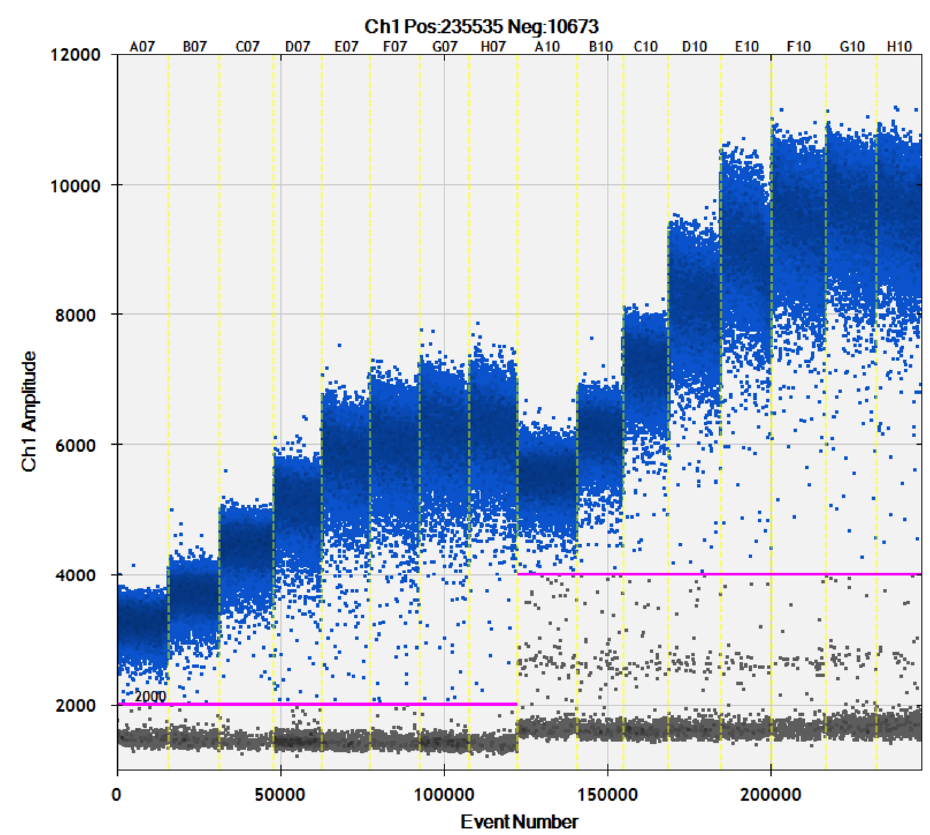
Figure 2. Robustness of ddPCR conditions for SET1 and SET2. The horizontal axis shows ddPCR amplifications using SD4.0 at different annealing/extension temperatures. Lanes 1 and 9: 65.0 ◦ C, lanes 2 and 10: 64.0 ◦ C, lanes 3 and 11: 62.4 ◦ C, lanes 4 and 12: 59.9 ◦ C, lanes 5 and 13: 57.0 ◦ C, lanes 6 and 14: 54.4 ◦ C, lanes 7 and 15: 52.9 ◦ C, and lanes 8 and 16: 52.0 ◦ C. Lanes 1 through 8 were amplified using SET1, and lanes 9 through 16 were amplified using SET2. The vertical axis shows PCR amplitudes (fluorescence intensity). Pink lines are detection thresholds.